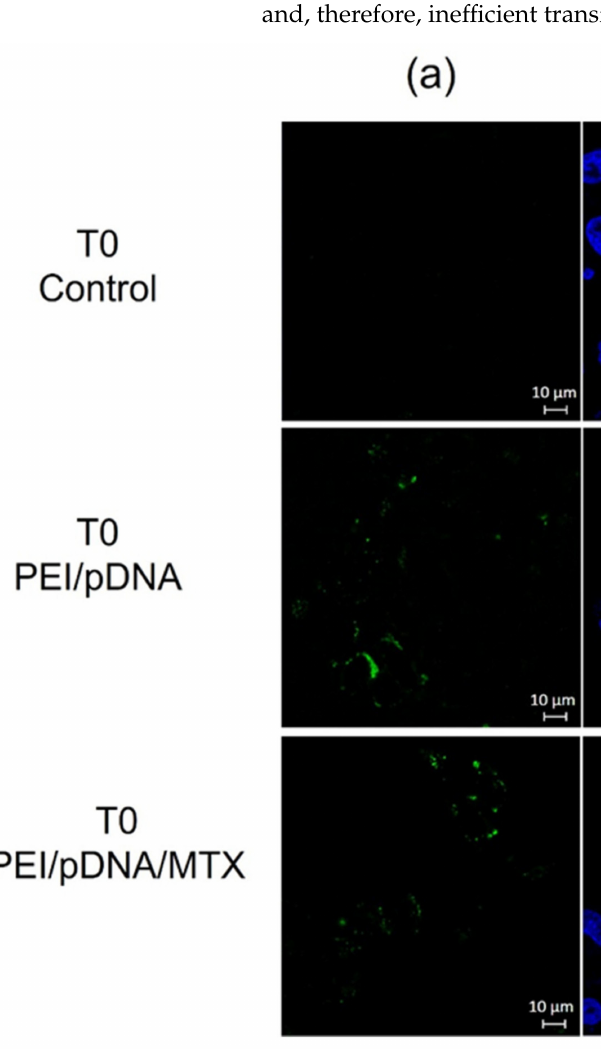
Figure 5. Cell live imaging experiment realized at T0 illustrating PEI/pDNA/MTX nanoparticles up- take/internalization in HeLa cells, and nucleus co-localization. ( a ) DAPI labeled nucleus; ( b ) pDNA green stained with FITC; ( c ) Merged image. Scale bar = 10 µ